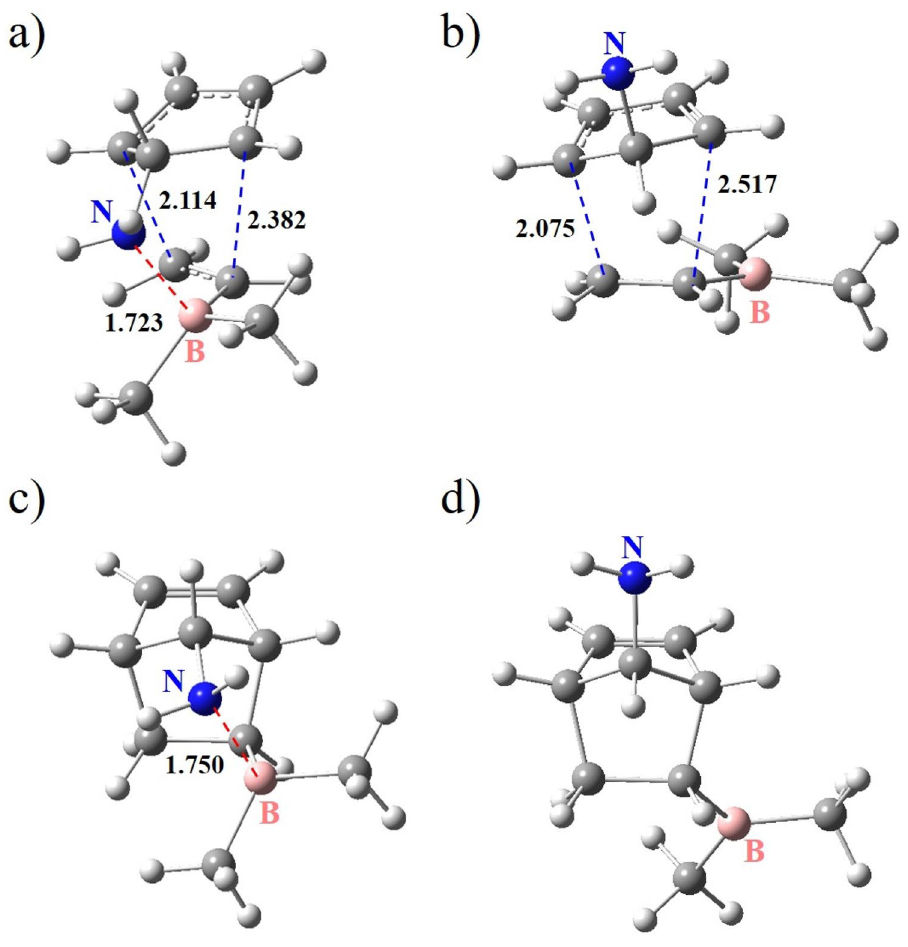
Figure 3. The optimized structures of the exo and endo TSs ( a and b ) and the corresponding final products ( c and d ) obtained for entry 1-2. The blue and red dashed lines represent the newly forming C–C bonds and the LAB interaction, respectively. The numbers indicate the adjacent bond length or atom–atom distance in angstroms.